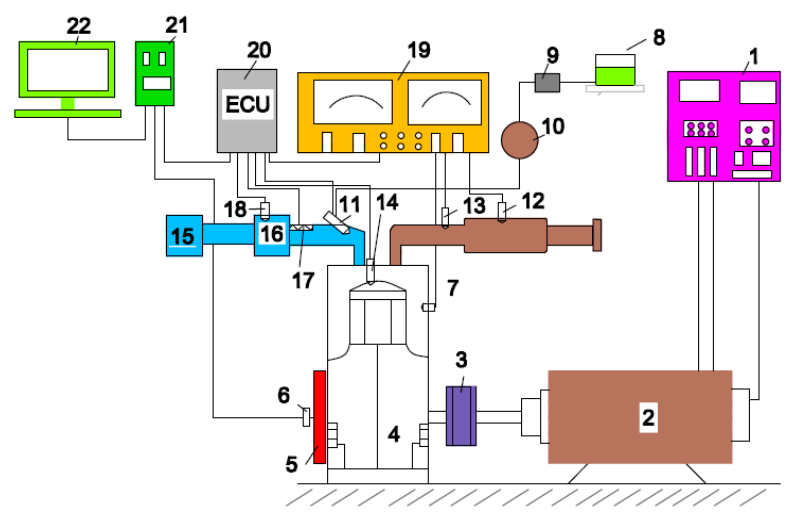
Figure 1. Schematic of the V-twin engine experimental setup.